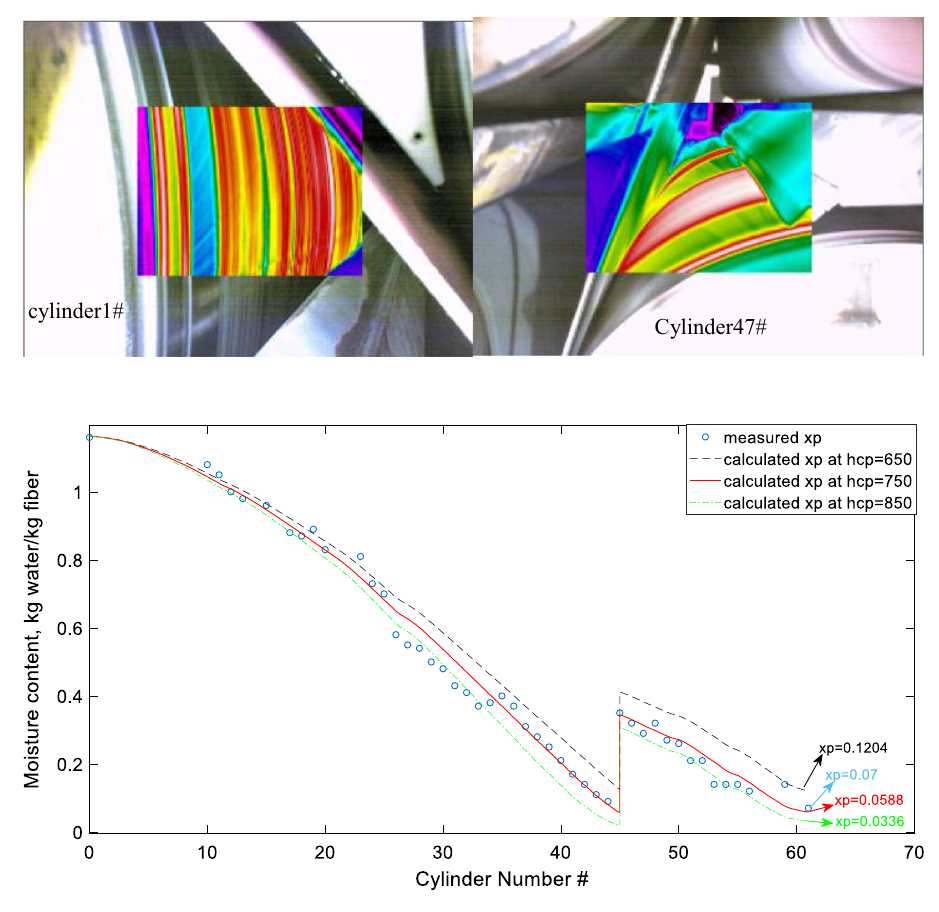
Fig. 4 IR pictures about the temperature of cylinder surface in 1 and 47# cylinder